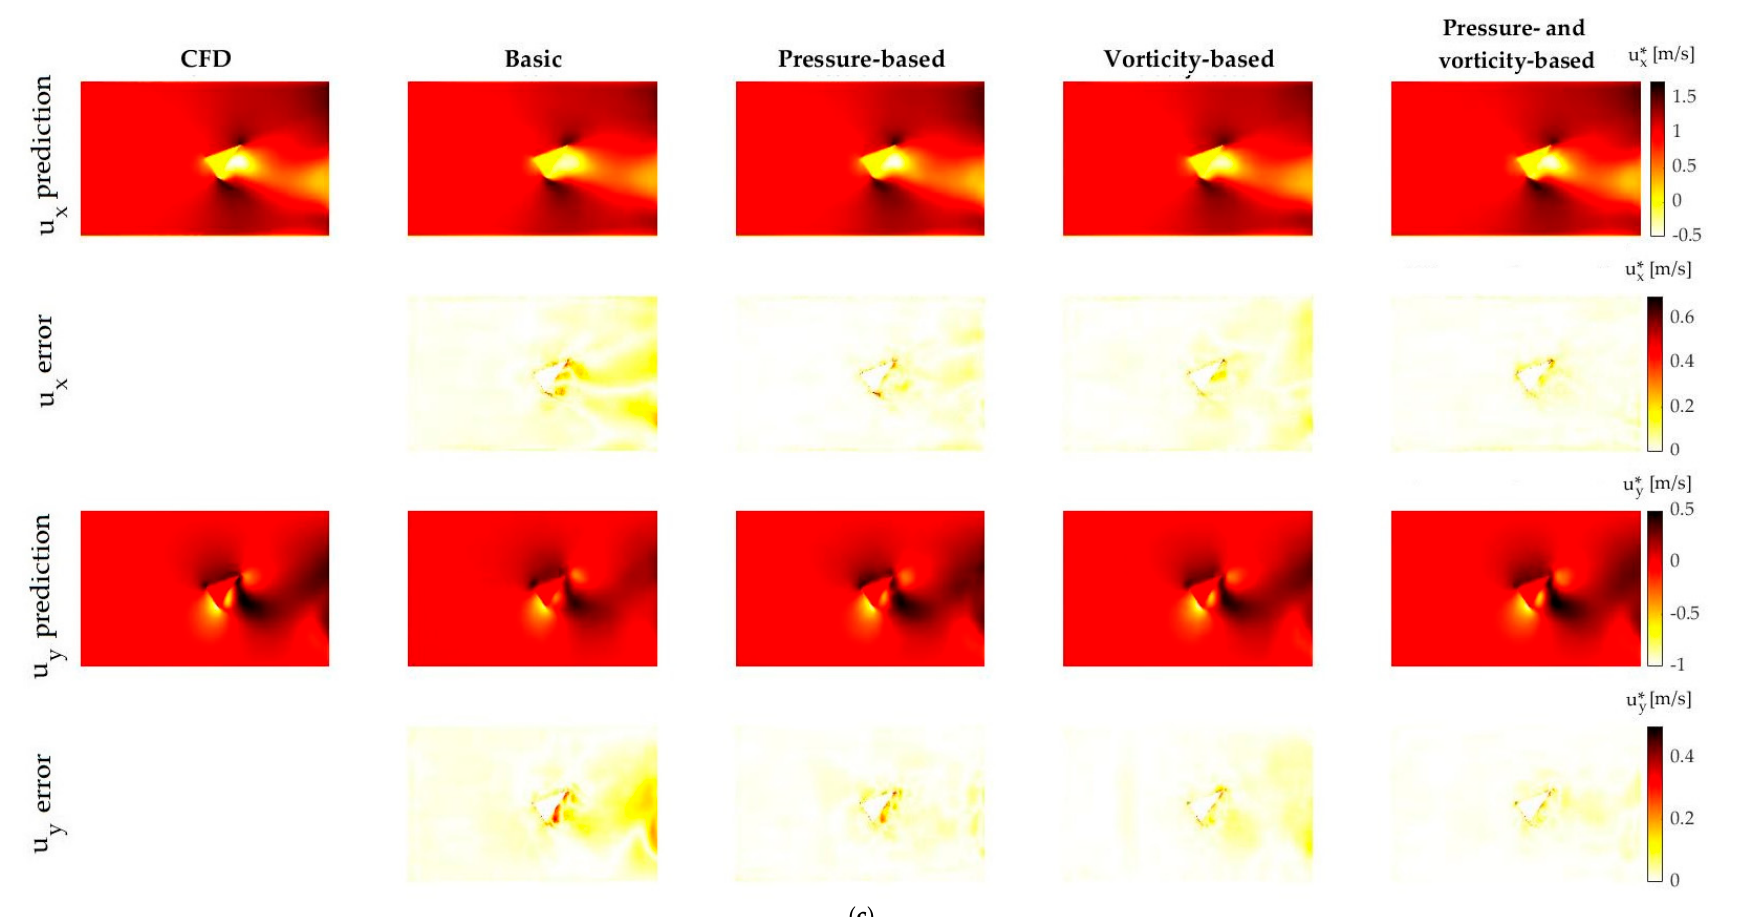
Figure 8. Qualitative comparison of the results obtained with the studied structures. ( a ) Easy-to-predict geometry; ( b ) Aerodynamic geometry; ( c ) Non-aerodynamic geometry.